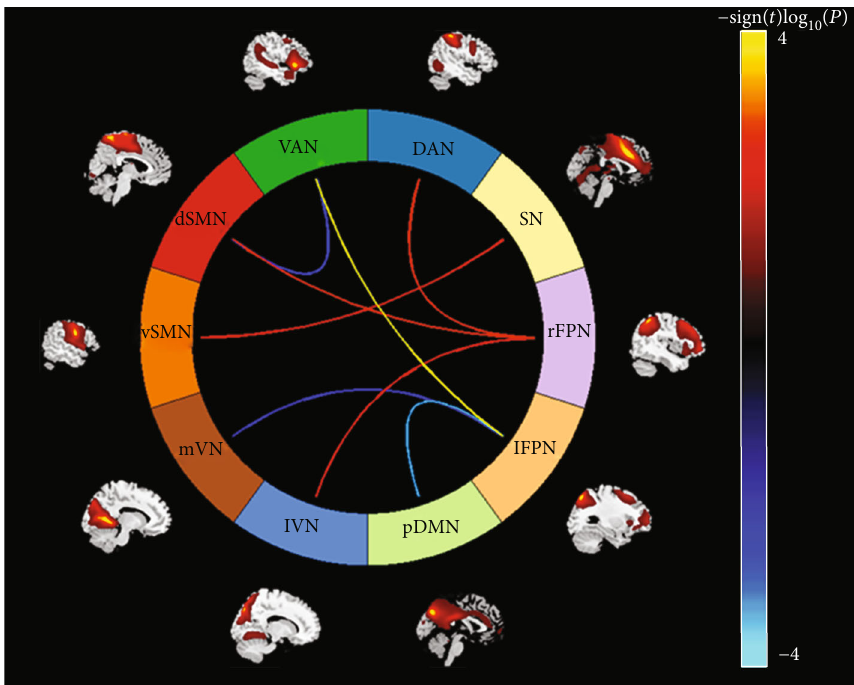
Figure 3: Associations between serum TG level and internetwork functional connectivity. Hot colors represent positive correlations, and cool colors represent negative correlations. Abbreviations: TG: triglyceride; pDMN: posterior default mode network; lFPN: left frontoparietal network; rFPN: right frontoparietal network; SN: salience network; DAN: dorsal attention network; VAN: ventral attention network; dSMN: dorsal sensorimotor network; vSMN: ventral sensorimotor network; mVN: medial visual network; lVN: lateral visual network.